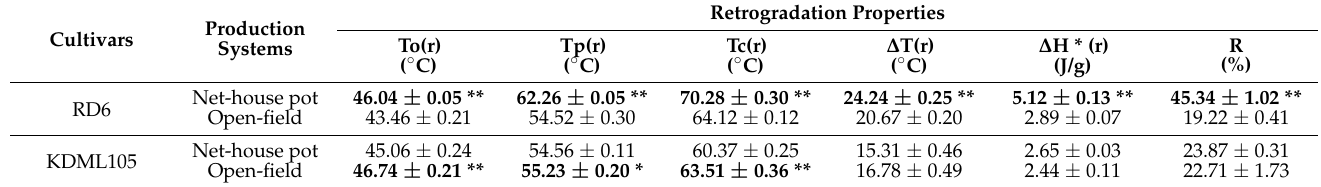
Values are means ± SEM. Means in bold within each column with the * and ** symbols denote statistically significant difference between the two production systems at p ≤ 0.05 and p ≤ 0.01, respectively, by Student’s t -test ( n = 3). Abbreviations: To(r) = onset temperature of retrograded starch; Tp(r) = peak temperature of retrograded starch; Tc(r) = conclusion temperature of retrograded starch; ∆ T(r) = temperature range of retrograded starch (Tc(r)—To(r)); ∆ H(r) = retrogradation enthalpy; and R (%) = the percentage of retrogradation. * Dry weight basis.